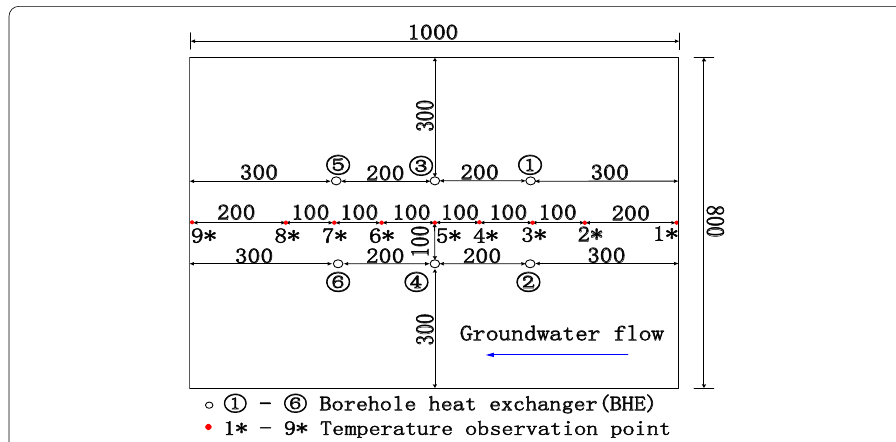
Fig. 4 Layout of BHEs and temperature observation points (unit: mm)